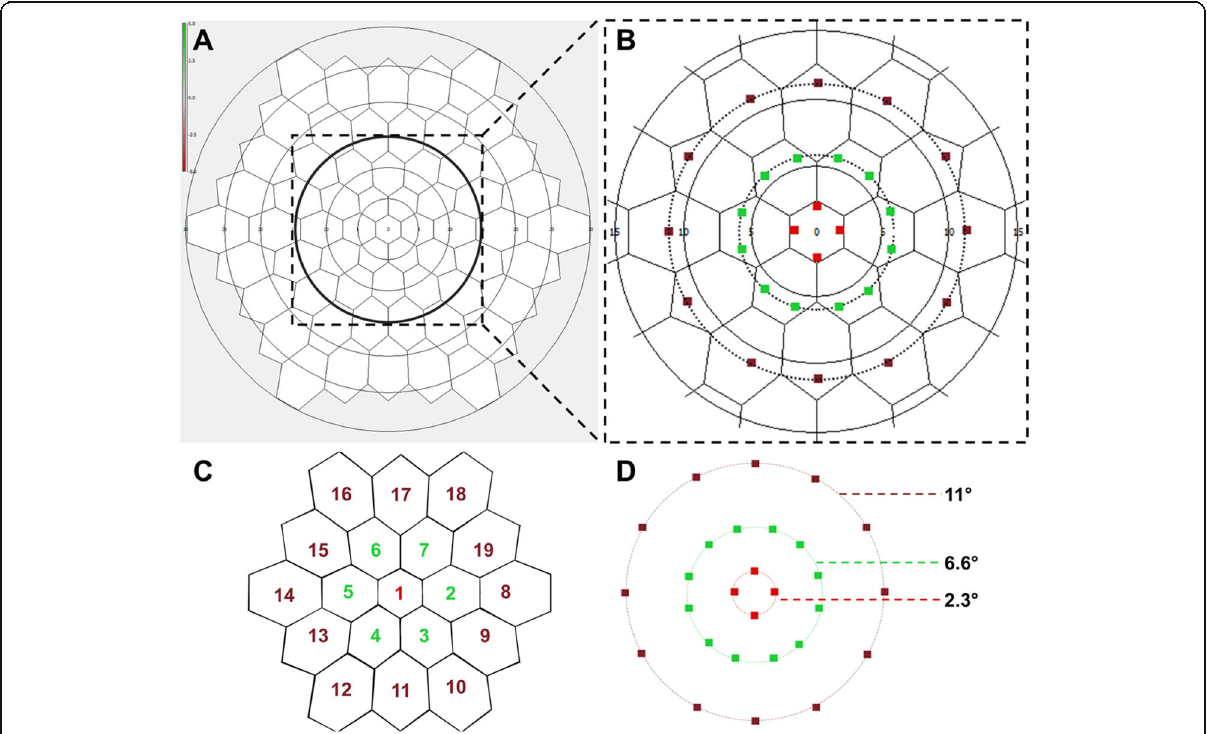
Fig. 1 An overlay and numbering scheme of the multifocal electroretinography (mfERG) hexagons and the microperimetry (MP) stimuli points. The hexagons ( n = 19) selected for the analysis are marked by a circle in a . In b , these 19 selected hexagons are overlapped with the MP test points using the exact distances from the foveal center. Thus, four central test points on MP lie on the inner hexagon (red color), two test points lie inside each hexagon in the second ring (green color), and one MP test point lies inside each hexagon in the outer ring (brown color). The nomenclature of the hexagons is depicted in c , where the central hexagon is labeled as 1. The distances from the foveal center of the MP test points is shown in